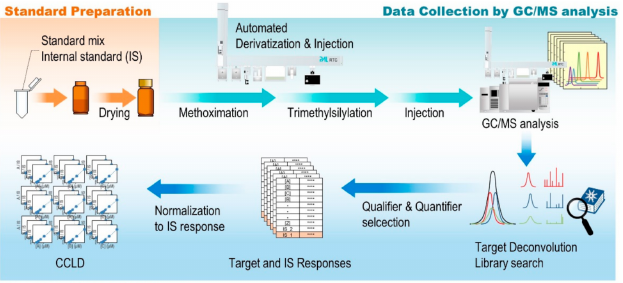
Figure 1. Conceptual diagram showing workflow for construction of a novel calibration curve locking database (CCLD) for metabolome analysis. The novel CCLD was constructed for semi-quantitative screening by gas chromatography/mass spectrometry (GC/MS). Our in-house CCLD contains the retention time (RT), calibration curve, and electron ionization (EI) mass spectrum for automatic compound search and semi-quantification of target compounds. To achieve repeatable quantification by using CCLD, automated batch and in-time sample derivatization and sample loading protocol by a PAL RTC system was employed for the construction of the CCLD.